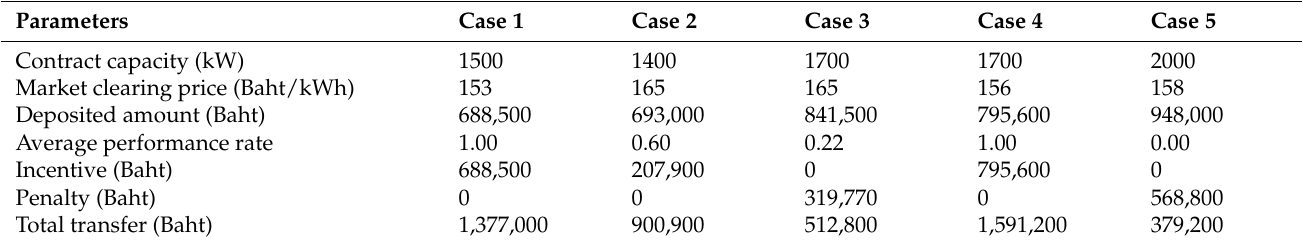
Table 4. Compensation and payments.